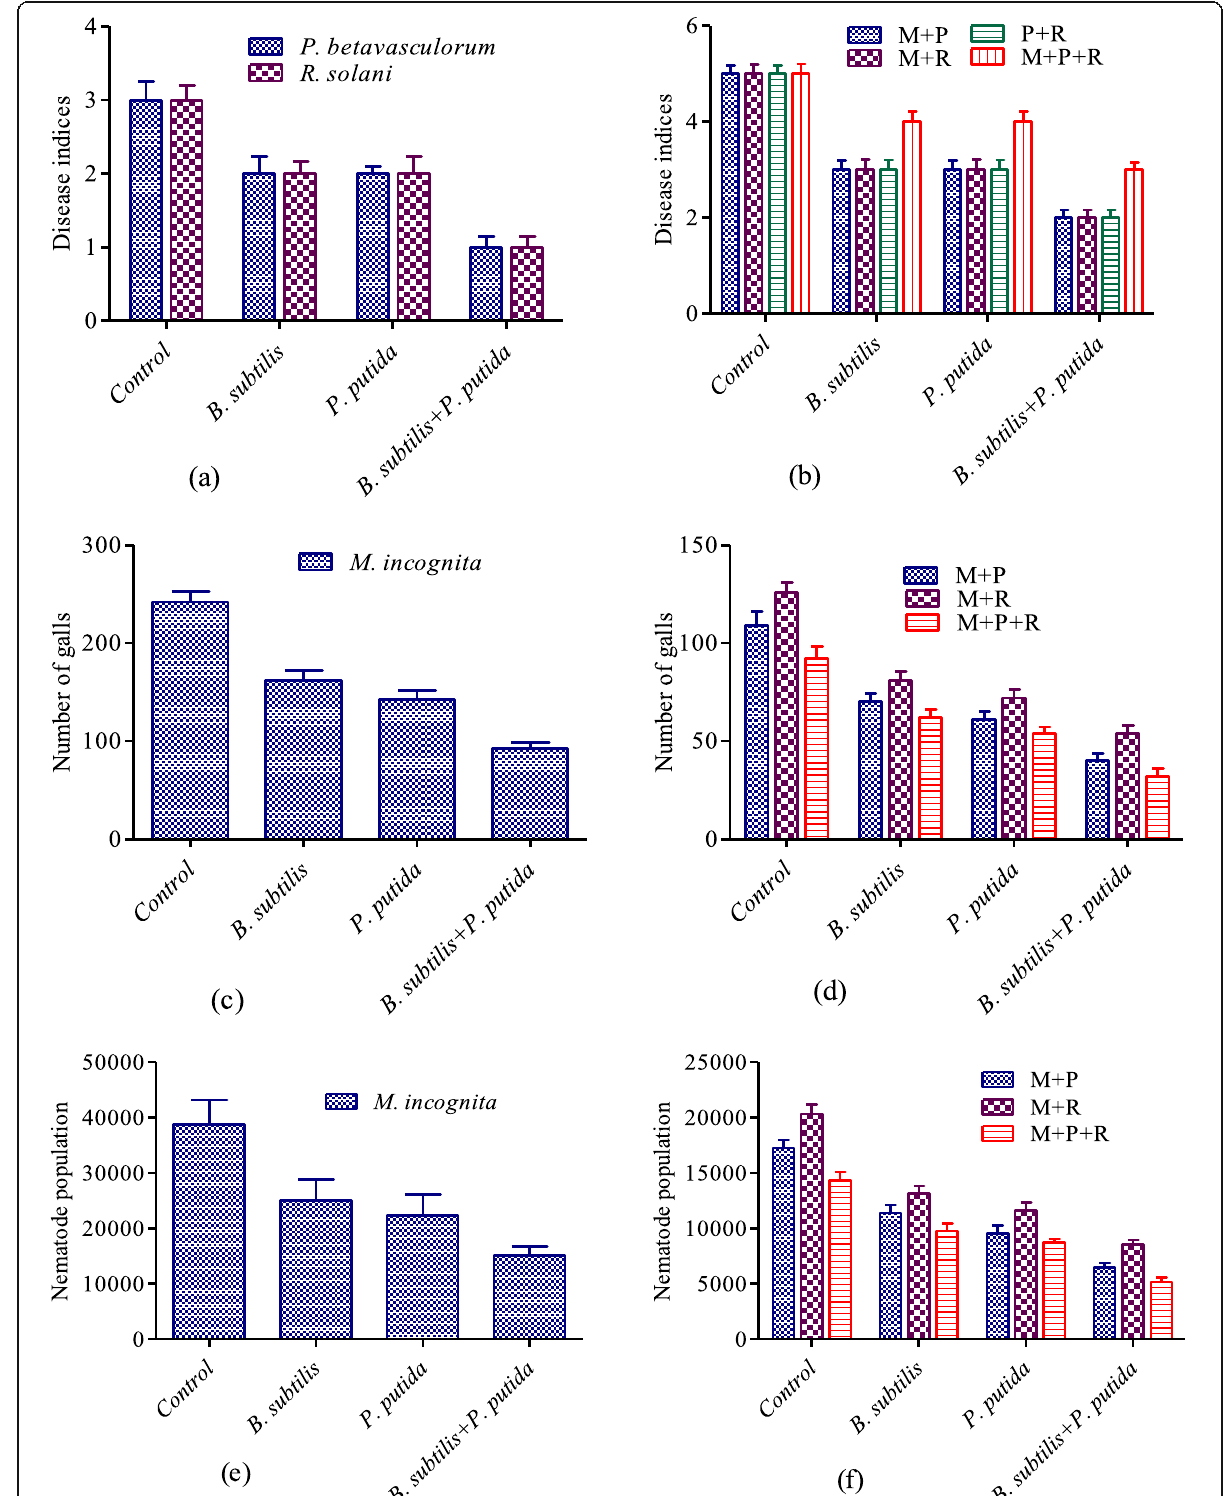
Fig 1 Effects of Pseudomonas putida , Bacillus subtilis , and their mixture on disease indices ( a , b ), root galling ( c , d ), and nematode multiplication ( e , f ) in beetroot infected with single, two or more pathogens. M Meloidogyne incognita , P Pectobacterium betavasculorum , and R Rhizoctonia